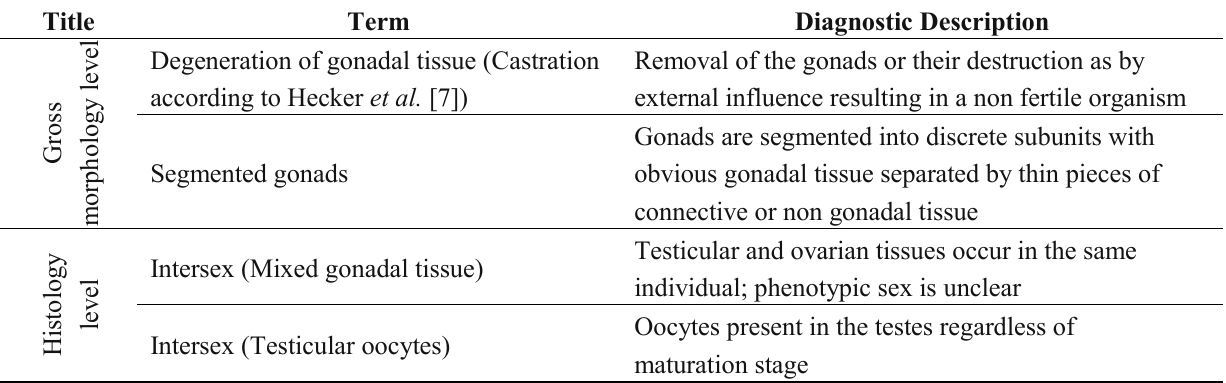
Table 1. Assessment and classification of gonadal anomalies in Liza ramada , according to Hecker et al. [7].